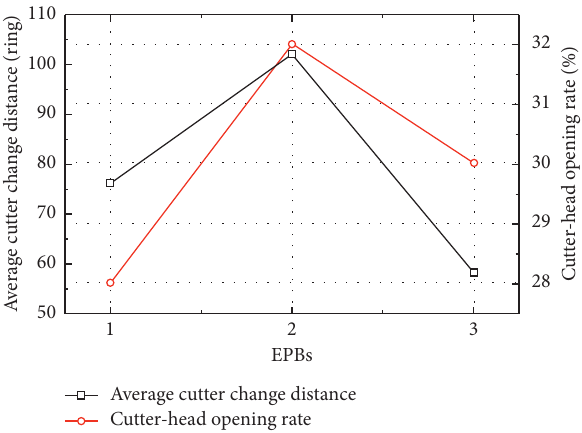
Figure 17: The comparison of the opening rate and average cutter change distance.